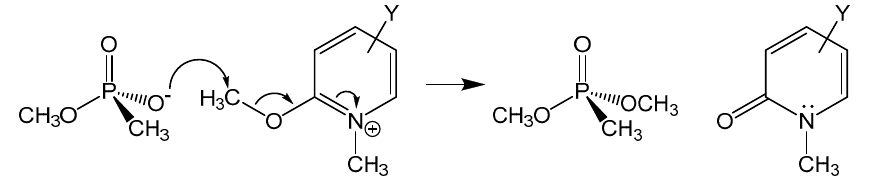
Figure 3. Substituted 2-Methoxy-1-methylpyridiniums as phosphonate anion methylating agents. Reactions were run in DMSO-d 6 at 25 °C and were monitored by 1 H-NMR spectroscopy [24].